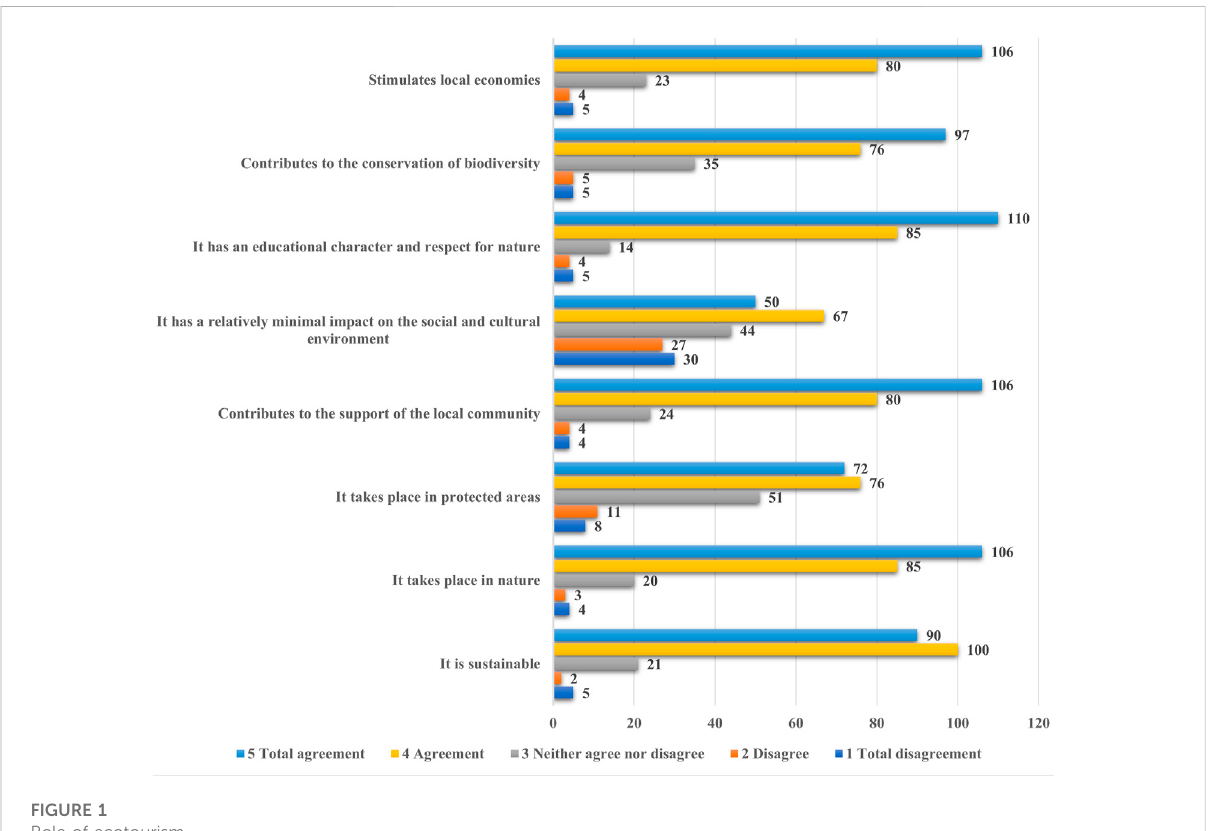
FIGURE 1 Role of ecotourism.